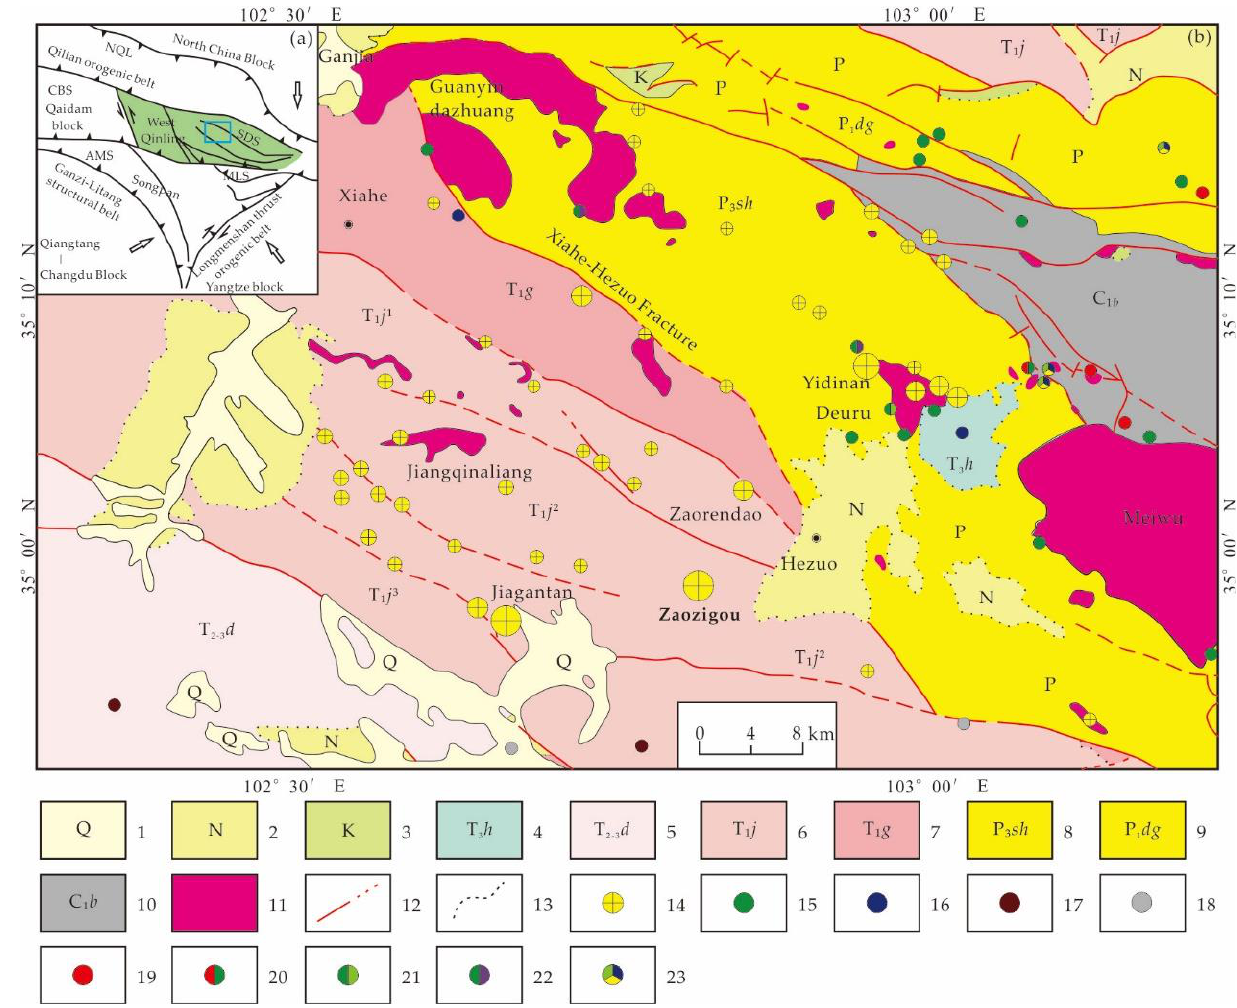
Figure 1. ( a ) Geotectonic location of the study area. NQL: North Qinling tectonic belt; SDS: Shangdan suture zone; CBS: Caibei suture zone; AMS: A’nyemaqen suture zone. ( b ) Geological map of Xiahe–Hezuo area (modified from [104]). 1. Quaternary; 2. Neogene; 3. Cretaceous; 4. Upper Triassic Huari group; 5. Middle-Lower Triassic Daheba group; 6. Lower Triassic Jiangligou group; 7. Lower Triassic Guomugou group; 8. Upper Permian Shiguan group; 9. Lower Permian Daguanshan group; 10. Upper Carboniferous Badu group; 11. Intermediate-acid intrusive rocks; 12. Fracture; 13. Angular unconformity; 14. Gold deposit; 15. Copper deposit; 16. Lead deposit; 17. Antimony deposit; 18. Mercury deposit; 19. Iron deposit; 20. Iron-copper deposit; 21. Copper-molybdenum deposit; 22. Copper-tungsten deposit.